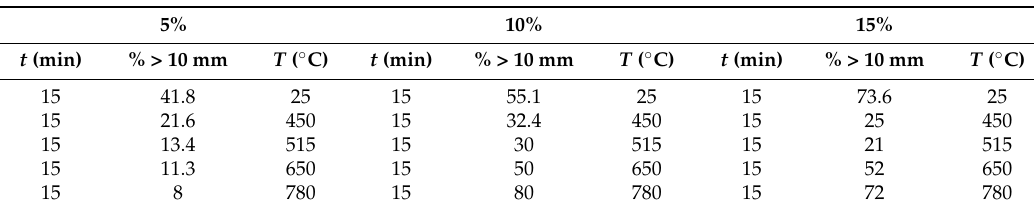
Table 2. Optimal percentage of refractory